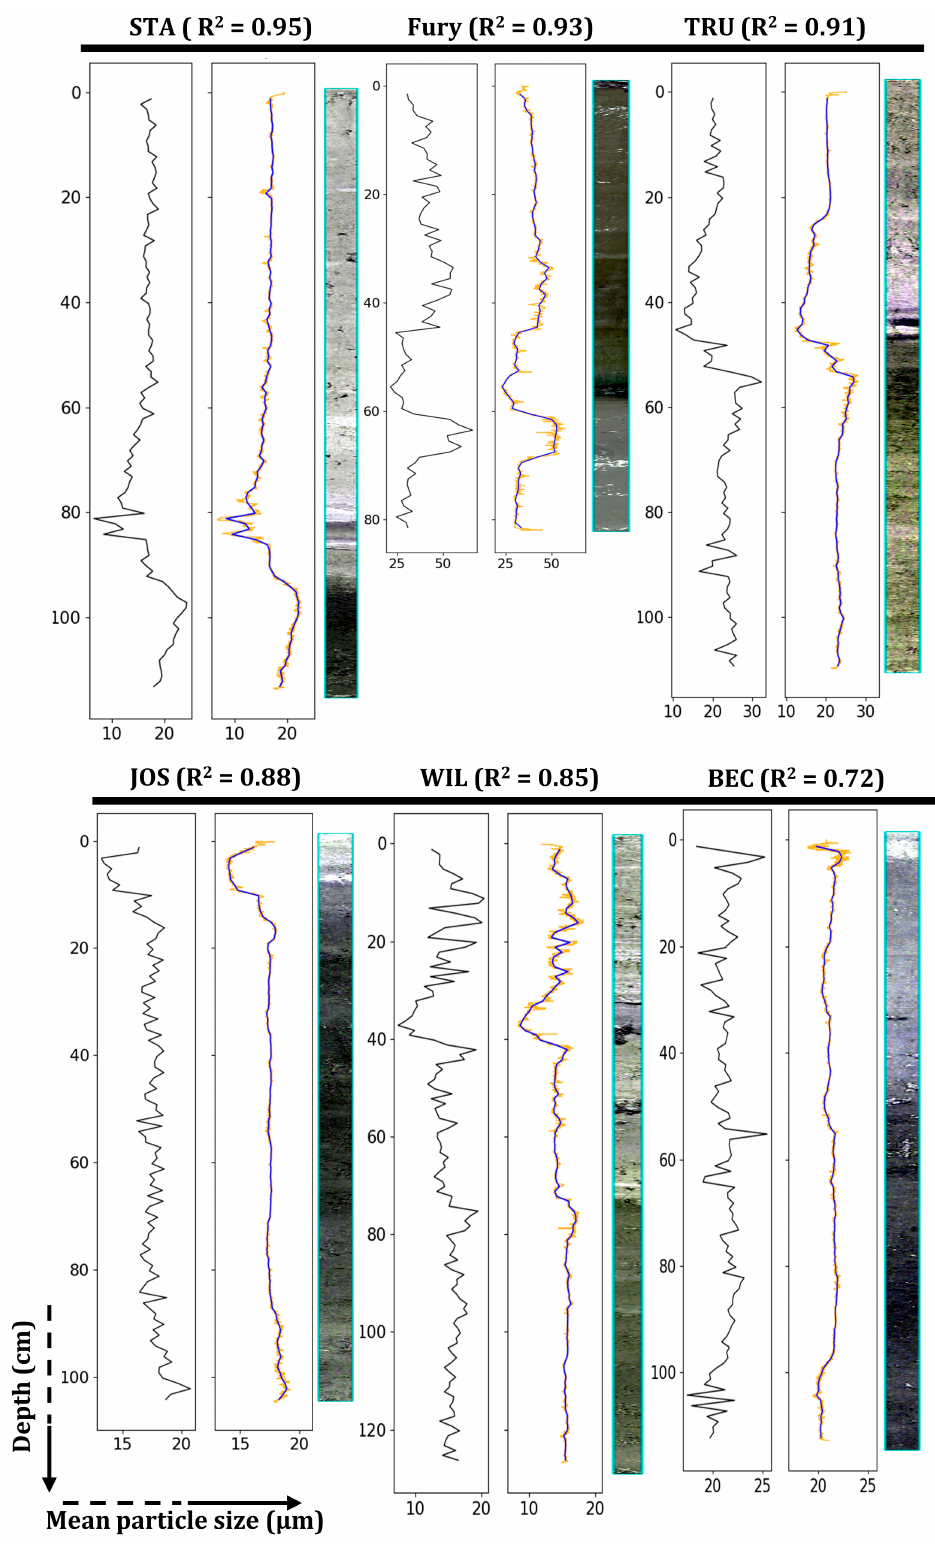
Figure 5. Measured mean particle size versus depth (left diagrams), and hyperspectral image-inferred values using the top-performing method (AB-RF method; right diagrams). Orange lines: high-resolution hyperspectral time series; blue lines: one-centimeter averages. At right are the enhanced RGB images of each sediment core.